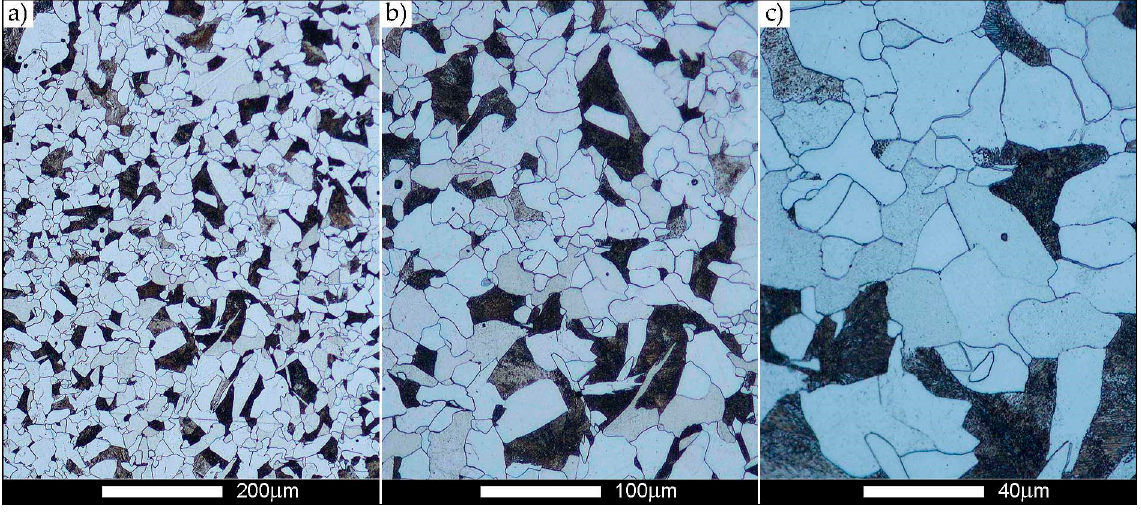
Figure 61. Welded joint microstructure of Hardox 450 steel with visible prior austenite grain boundaries, austenitised at 1100 °C—HAZ zone. ( a ) 100×; ( b ) 200×; ( c ) 500×.